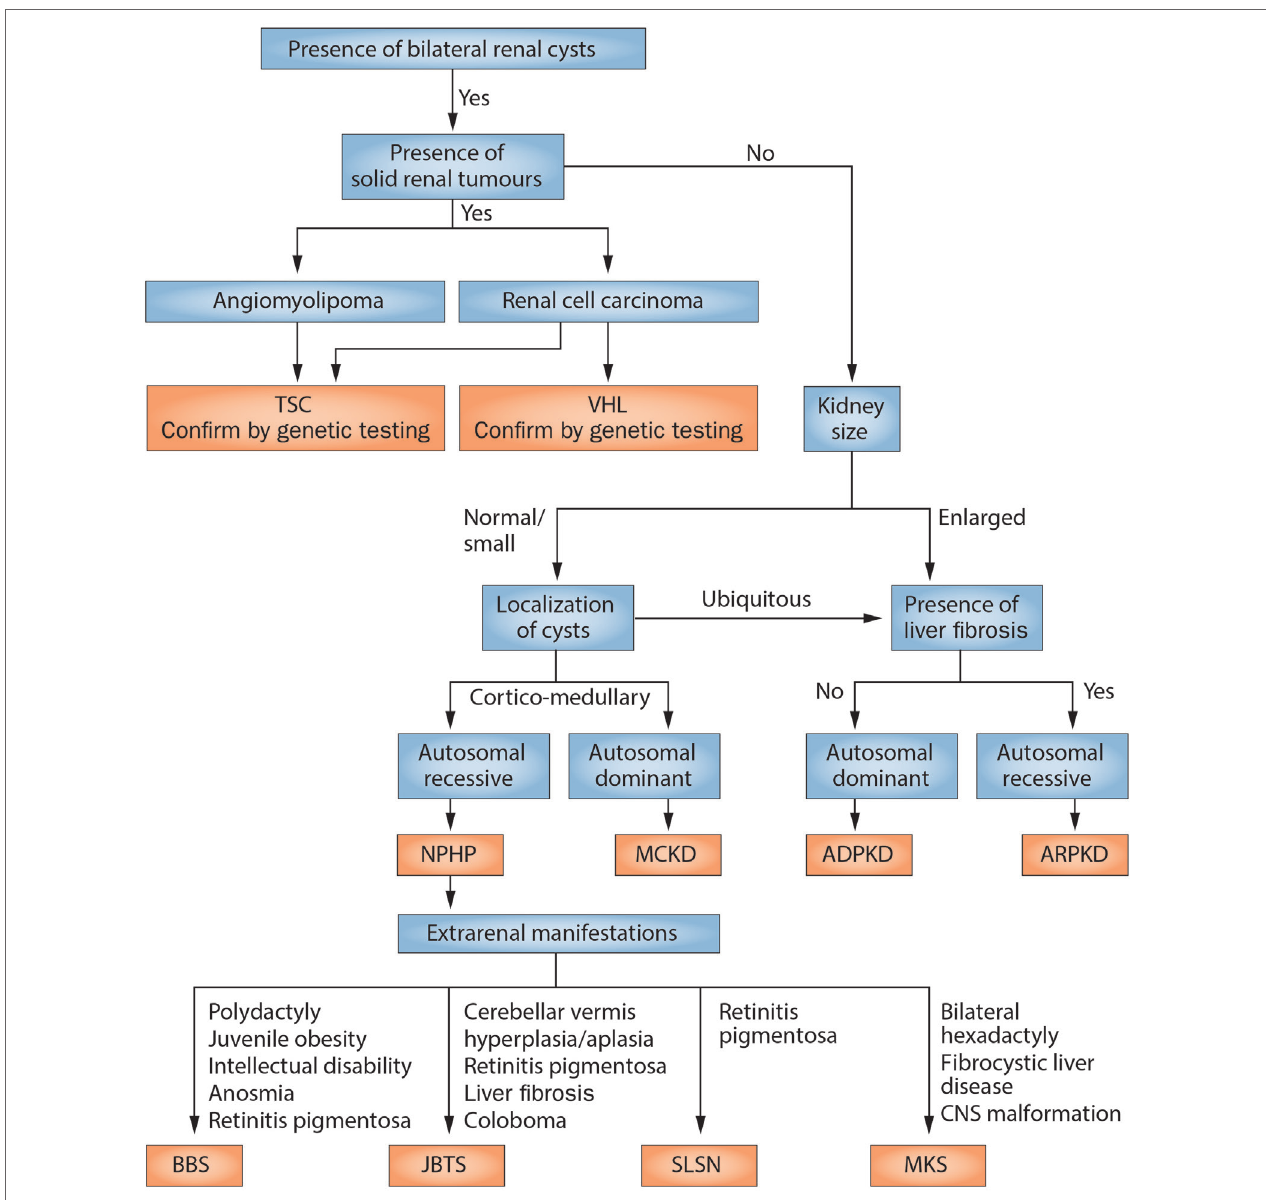
FiGURe 2 | Scheme of the diagnostic algorithm for polycystic kidney diseases combining clinical judgment with imaging modalities and molecular genetics. From Kurschat et al. (20). NPHP, nephronophthisis; MCKD, medullary cystic kidney disease (better to be termed now: autosomal-dominant tubulointerstitial disease); BBS, Bardet–Biedl syndrome; JBTS, Joubert syndrome; SLSN, Senior–Loken syndrome; MKS, Meckel–Gruber